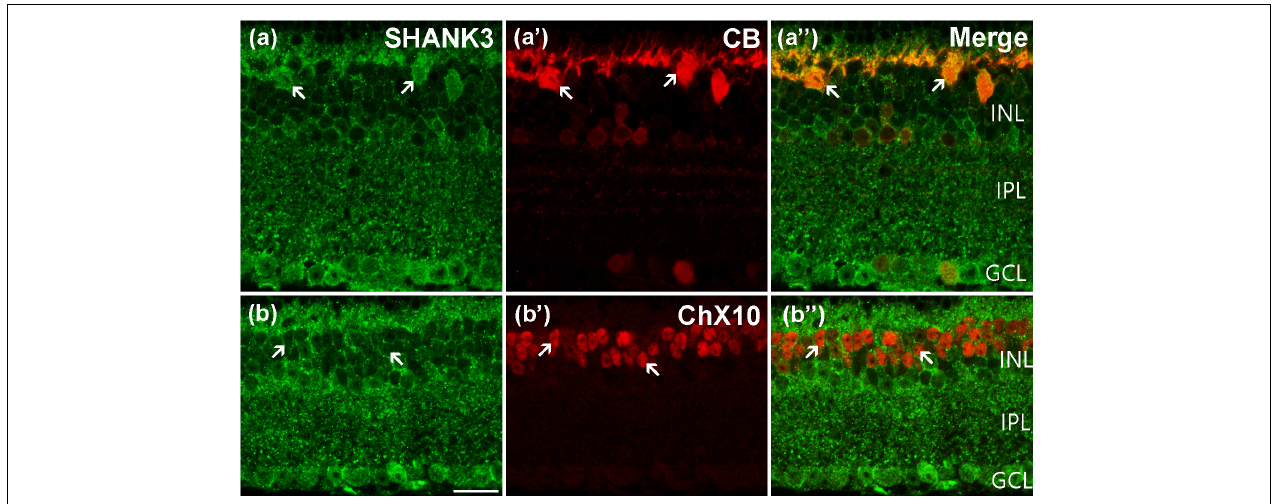
FIGURE 3 | Confocal microphotographs showing the distribution of SHANK3 in the outer retina. Double-labeled elements (green for SHANK3; red for CB and ChX10) appear yellowish and some double-labeled cells are indicated by arrows. (a–a”) Colocalization of SHANK3 with CB in a retinal vertical section. Fluorescence double stainings show that SHANK3 (a) and the CB (a’) , the merged image of CB and SHANK3 (a”) . CB-labeled horizontal cells (a’) . The CB-positive somata (arrows) are colabeled by SHANK3 (a,a”) . (b–b”) Colocalization of SHANK3 with ChX10 in a retinal vertical section. Fluorescence double stainings show that SHANK3 (b) and the ChX10 (b’b”) is the merged image of ChX10 and SHANK3. ChX10 is a marker for bipolar cells. Note that labeling for SHANK3 is detected in ChX10-positive BCs (arrows). Scale bar = 20 µ m.